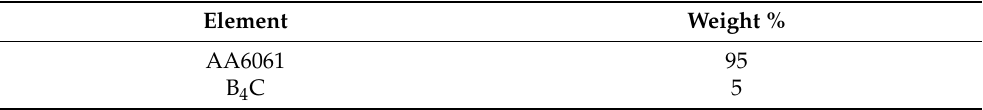
Table 3. The composition of boron carbide reinforces the AA6061